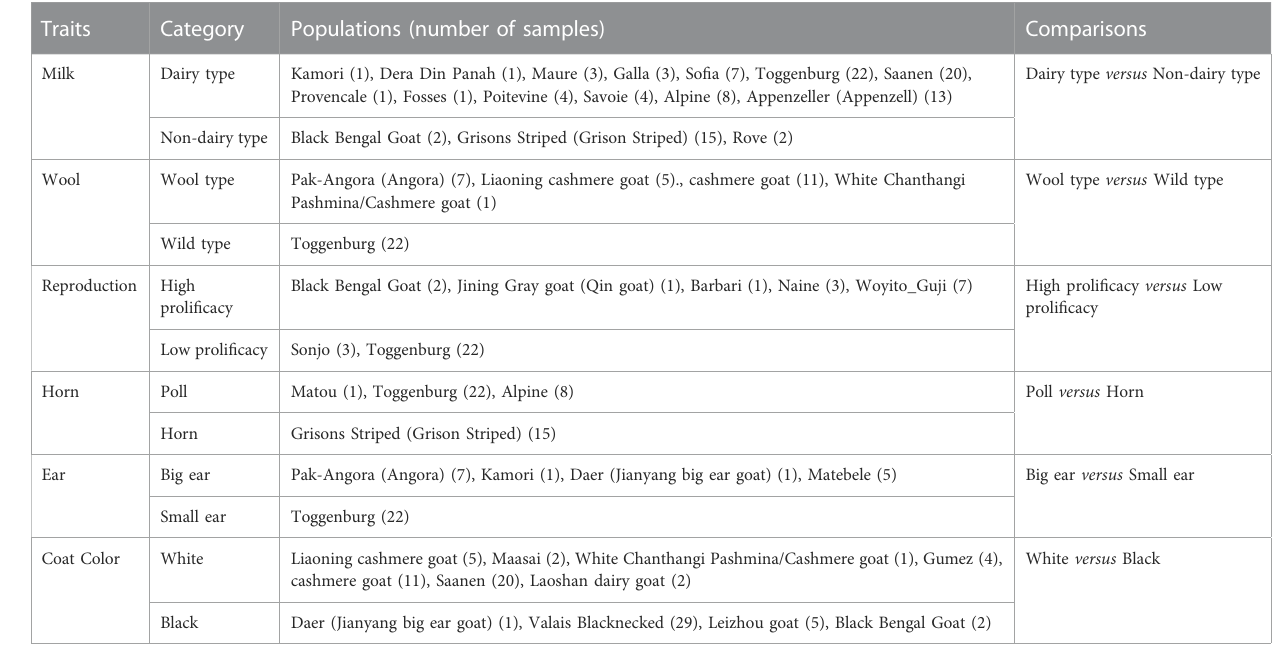
TABLE 1 Information from worldwide goat breeds used to detect selective signals associated with speci fi c traits.